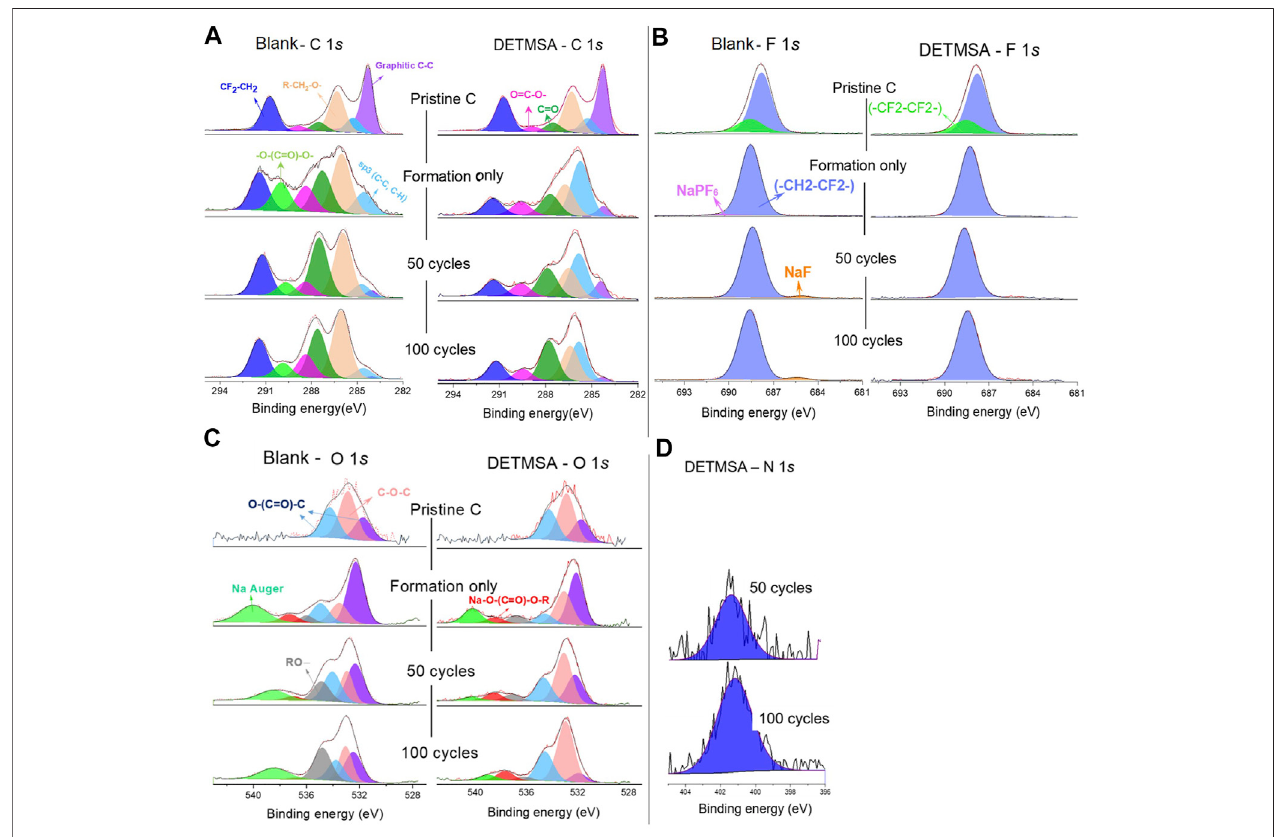
FIGURE 4 | The XPS spectra of pristine hard-carbon electrodes and those electrodes after formation, after 50 cycles, and after 100 cycles by using blank and DETMSA electrolytes. (A) the C 1s, (B) O 1s, (C) F 1s, and (D) N 1s spectra of the hard-carbon electrodes.